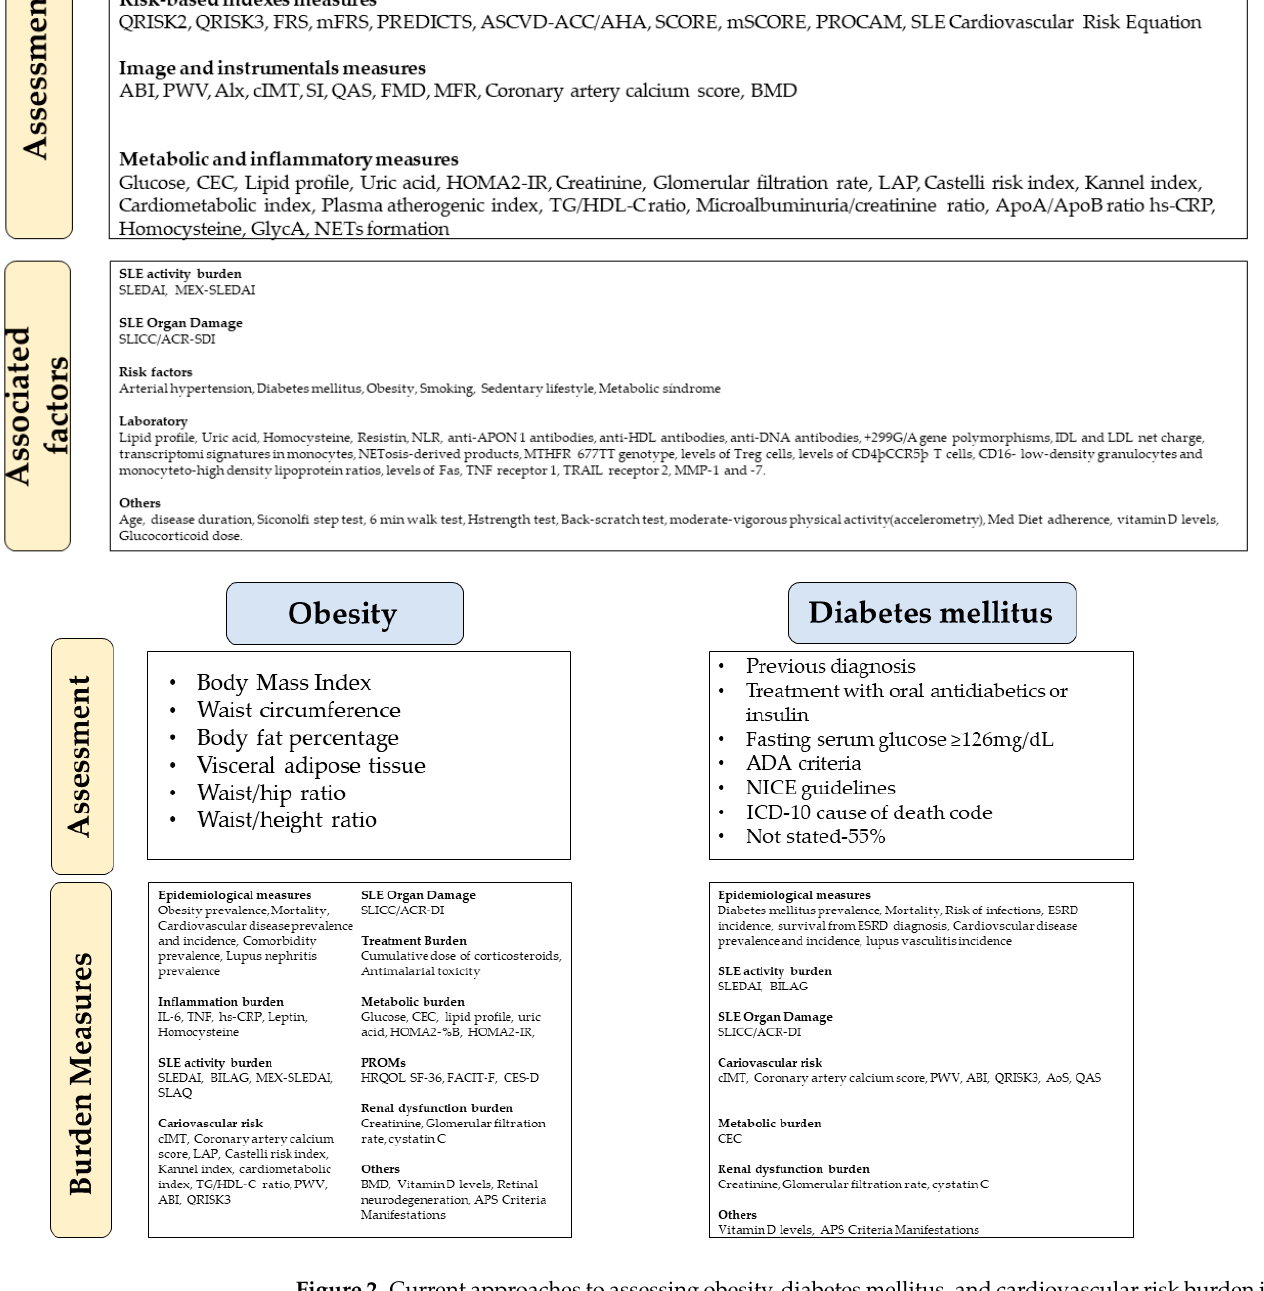
Figure 2. Current approaches to assessing obesity, diabetes mellitus, and cardiovascular risk burden in SLE patients. ( ABI: Ankle Brachial Index. ADA: American Diabetes Association. Alx: Augmentation index. AoS: Aortic stiffness. APS: Antiphospholipid syndrome. ASCVD-ACC/AHA: Pooled Cohort Risk Equations-American College of Cardiology/American Heart Association. BILAG: British Isles Lupus Assessment Group. BMD: Bone mineral density. CEC: Cholesterol Efflux Capacity.